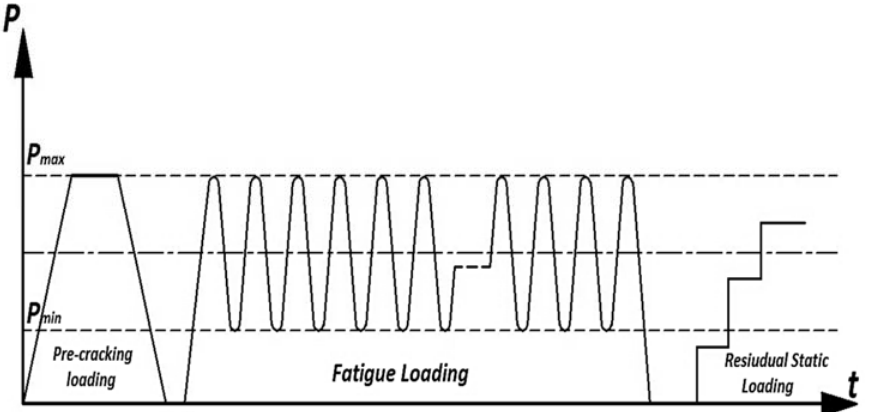
Figure 4: Used cyclic loading pattern [9].